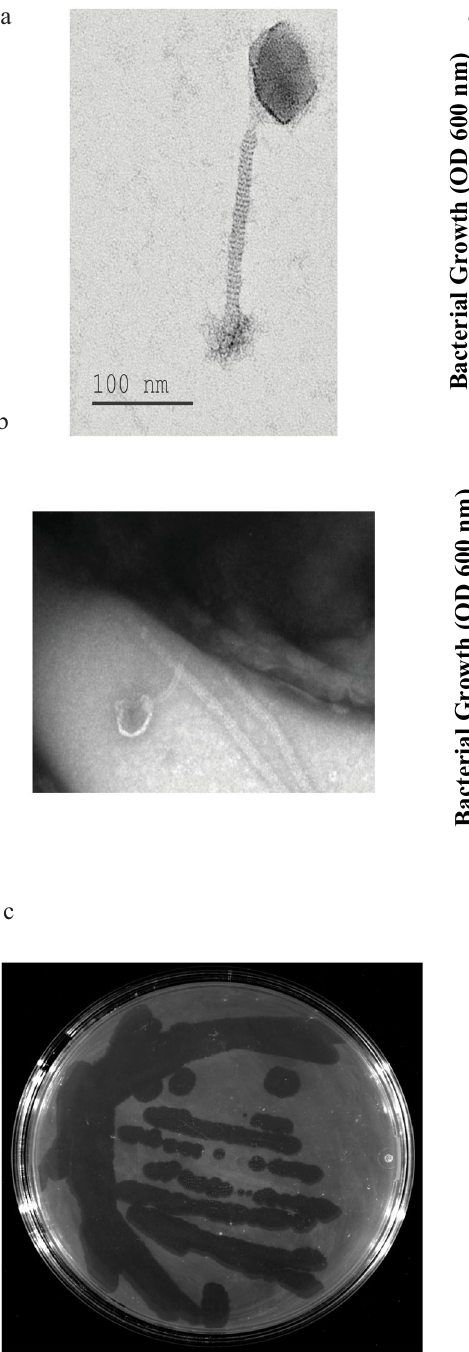
Fig. 2 | In-vitro phage ef fi cacy and morphology. a , b Transmission electron microscopy of phage FD1 and FD1 bound to its bacterial target ( b ). In addition, images of all phages are presented in Supplemental Fig. S2a. This experiment was done twice( c ) FD1plaques on Cutibacterium acnes strain27. Note the diverse sizes of plaques, althoughtheyoriginate from a singleplaque. d The CM-resistant strain